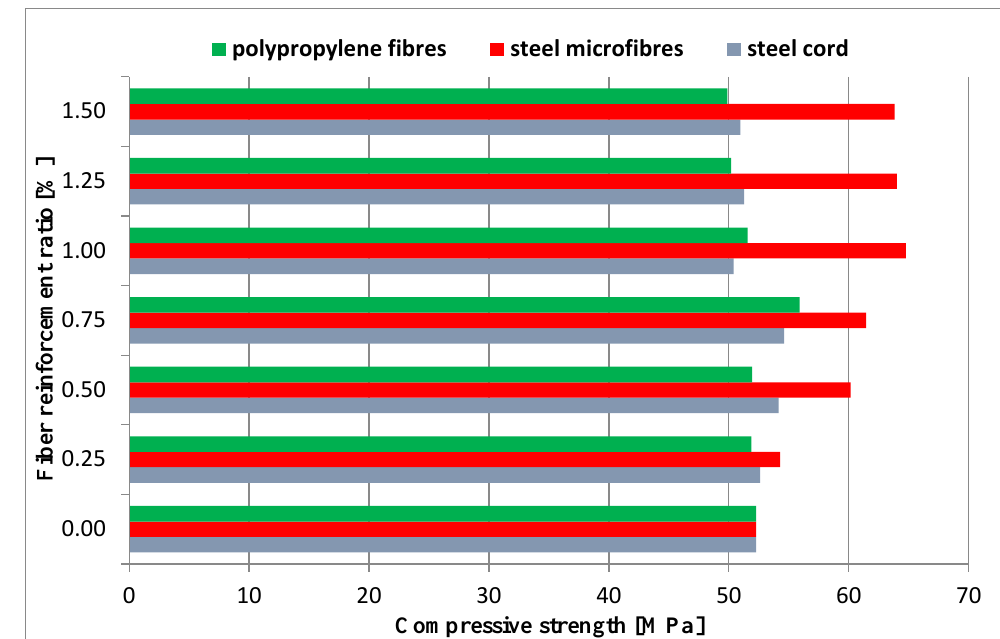
Figure 13. Compressive strength values of tested mixtures.